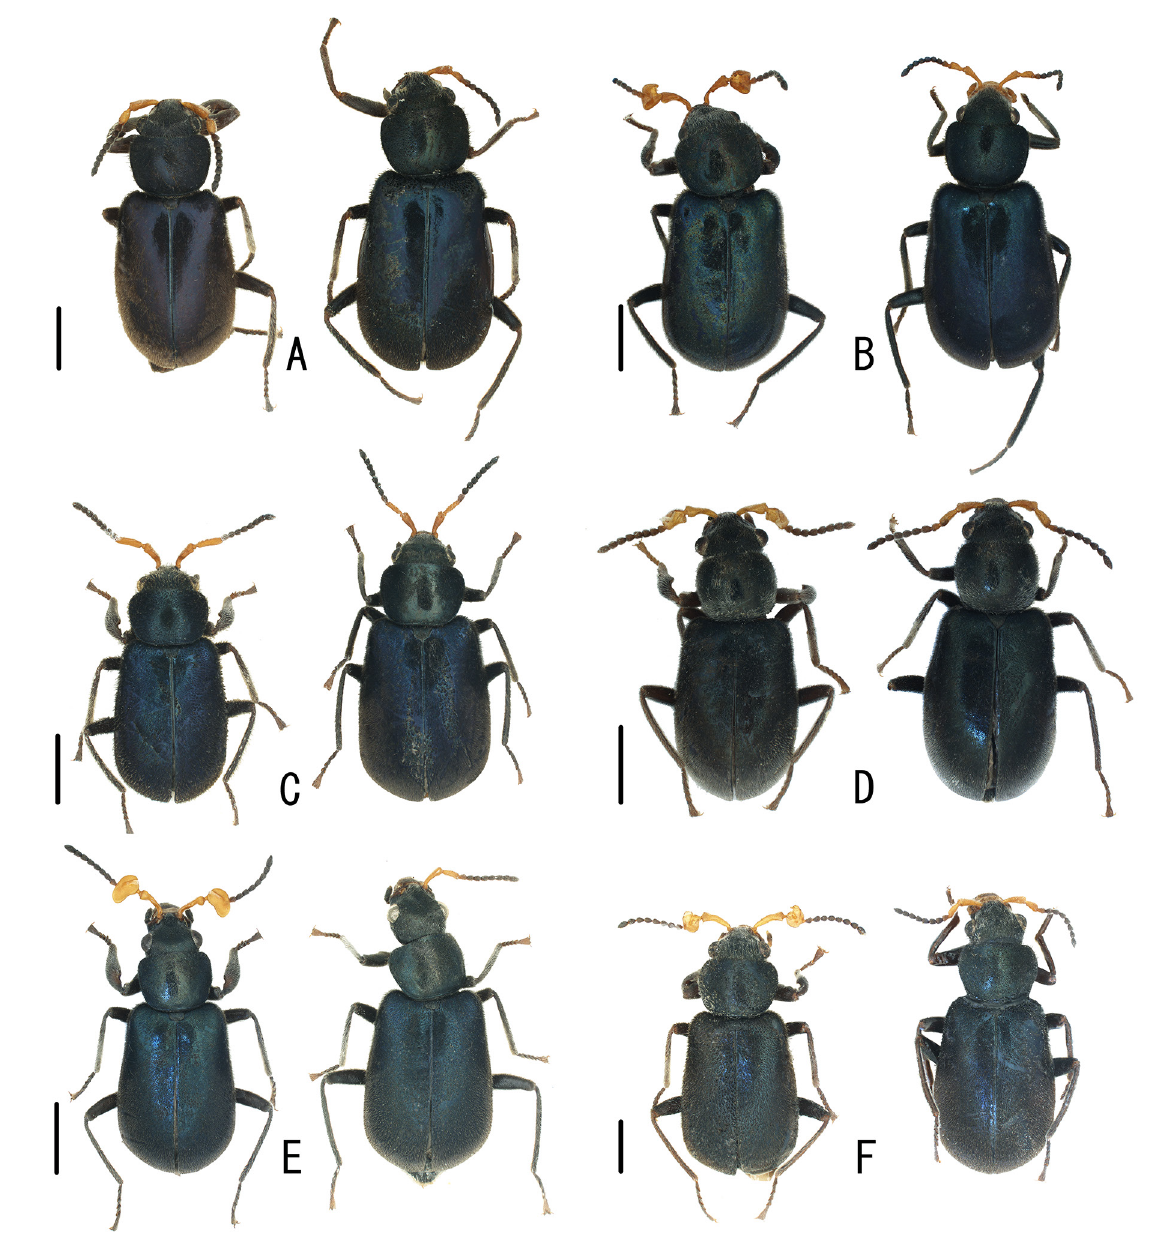
Fig. 6. Dorsal habitus of Laius spp. (left: ♂; right: ♀). A . Laius maai Wittmer, 1973 (paratype). B . L. marchei Pic, 1922. C . L. politus Fairmaire, 1880. D . L. sabangensis Wittmer, 1985 (paratype). E . L. sericatus Champion, 1924. F . L. submariniformis Wittmer, 1985 (paratype). Scale bars = 1.0